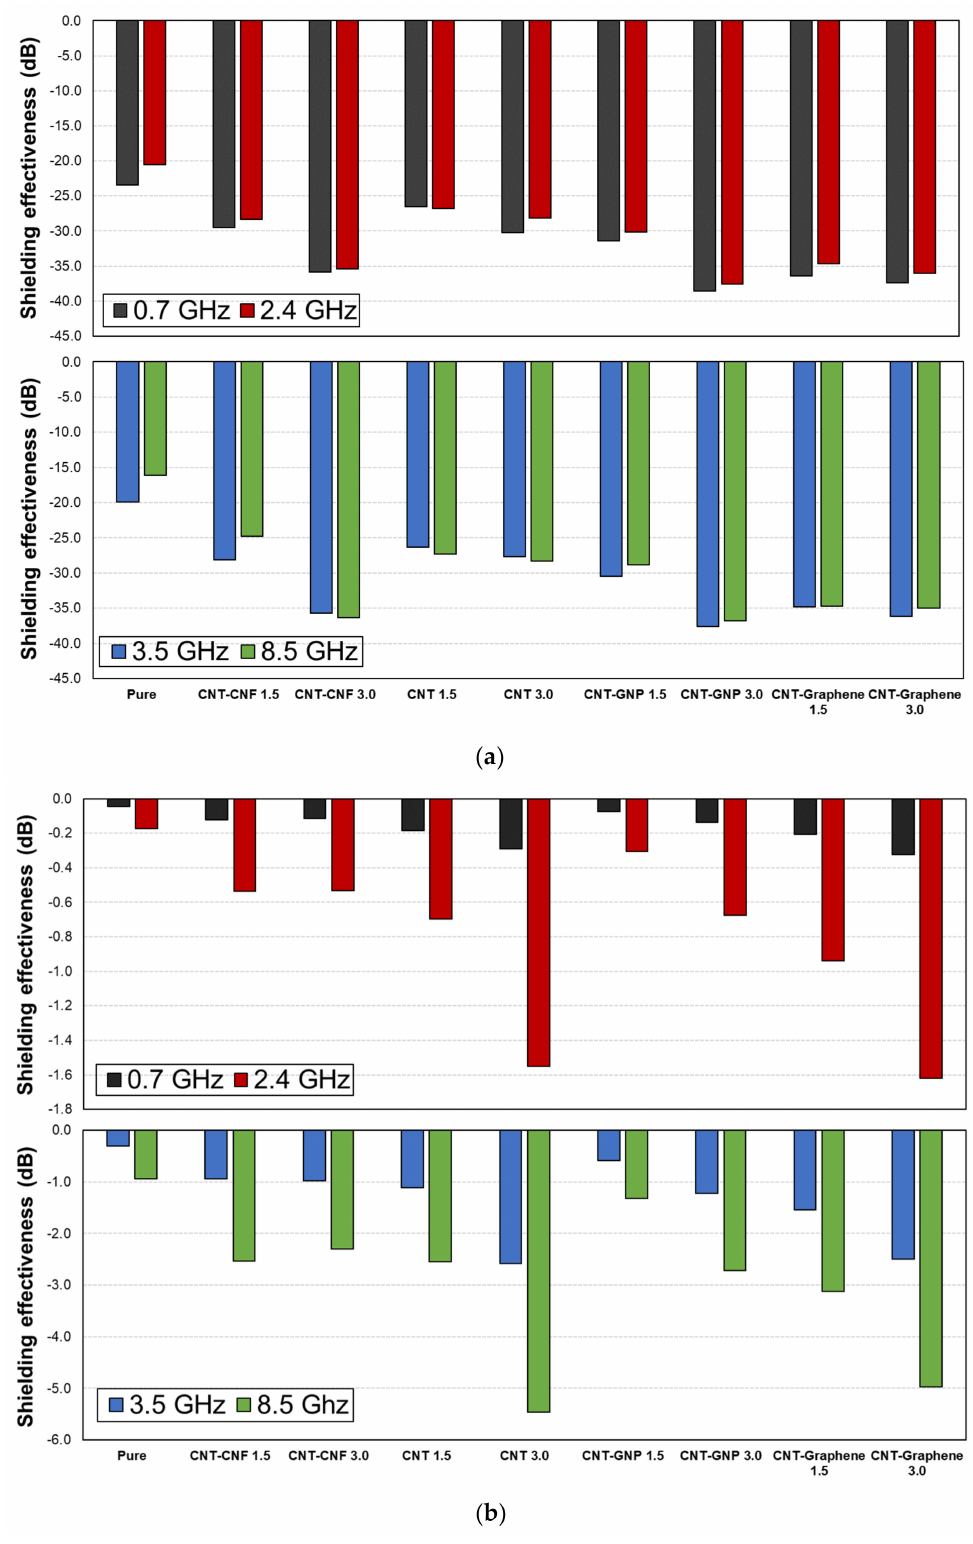
Figure 3. EMI shielding effectiveness of ( a ) CFRP and ( b ) GFRP samples at representative frequencies (0.7, 2.4, 3.5, and 8.5